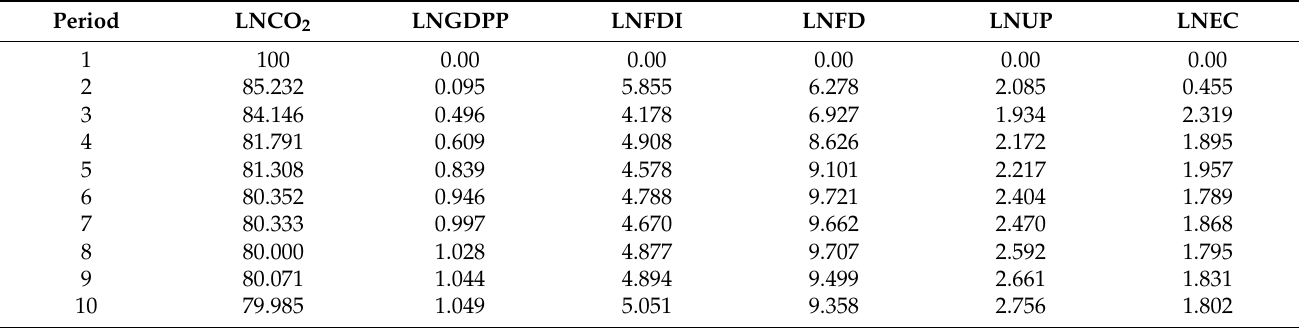
Table 9. Variance Decomposition of